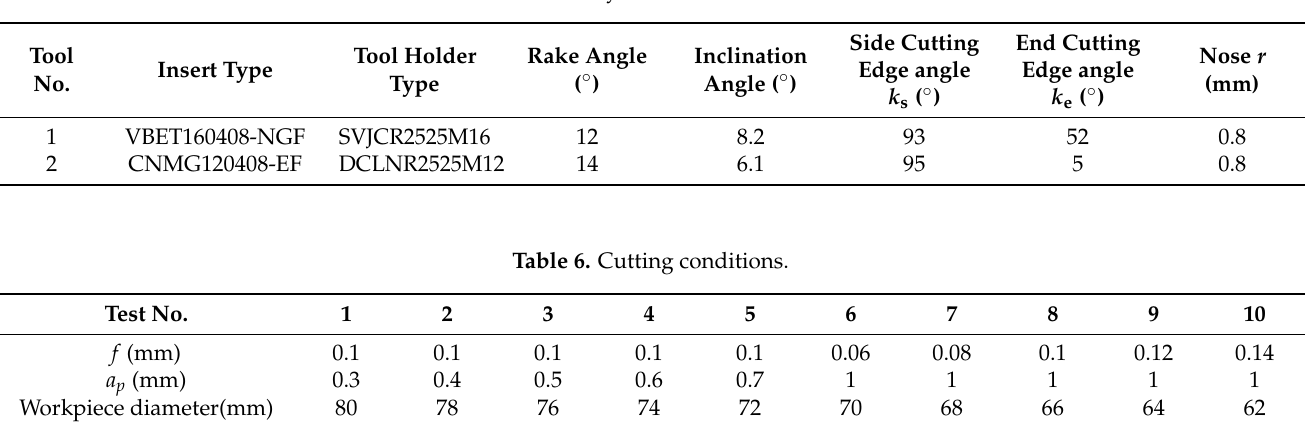
Table 5. Geometry of insert and tool holder.